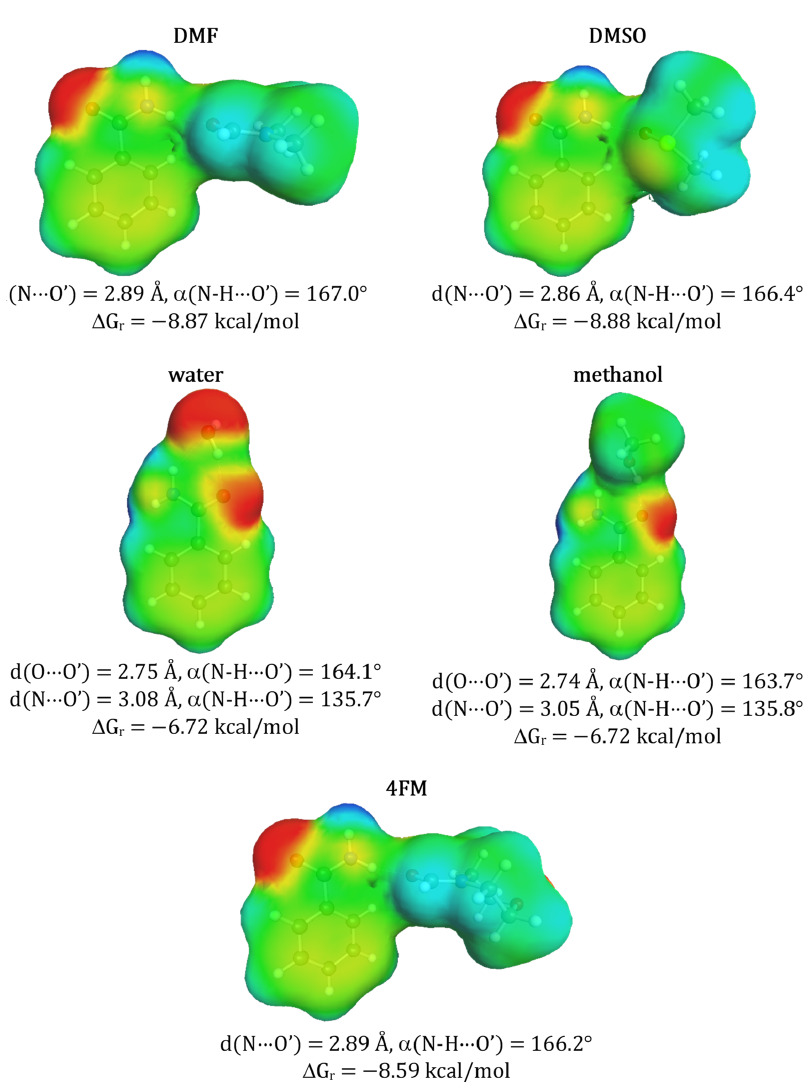
Figure 1. Structural and thermodynamic characteristics of selected solute-solvent contacts of benzamide. The affinity measure ( Δ G r ) represents concentration-independent value associated with activity constant of the corresponding reaction of pair formation at room temperature. Prime denotes atoms belonging to solvent molecules.